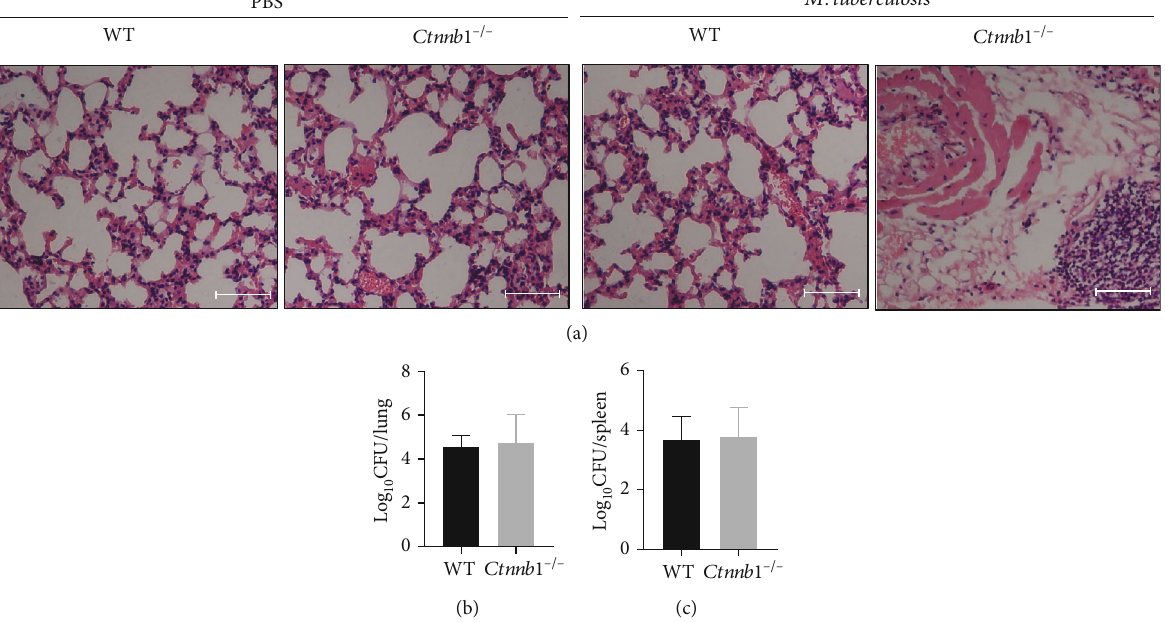
Figure 3: Histopathology and bacterial load of lungs (and spleens) of mice with Mtb infection in vivo. (a) Representative histopathology in lung sections stained with haematoxylin and eosin (H&E) of wild-type mice and Ctnnb1 -/- mice infected with or without M. tuberculosis for 4 weeks (bar, 100 μ m; original magni fi cation × 200). (b) Bacterial load (cfu) in the lungs of both Ctnnb1 -/- ( n = 5 ) and wild-type mice ( n = 5 ) infected with M. tuberculosis for 4 weeks. (c) Bacterial load (cfu) in the spleens of both Ctnnb1 -/- ( n = 5 ) and wild-type mice ( n = 5 ) infected with M. tuberculosis for 4 weeks. The experiment had three independent rounds, and results were analyzed by the unpaired Student t -test. PBS, phosphate-bu ff ered